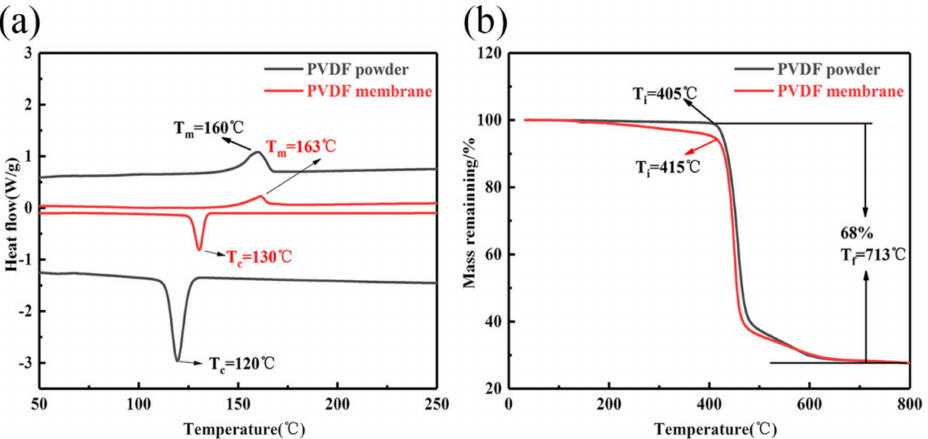
Figure 6. Changes in PVDF molecular structure during electrospinning.